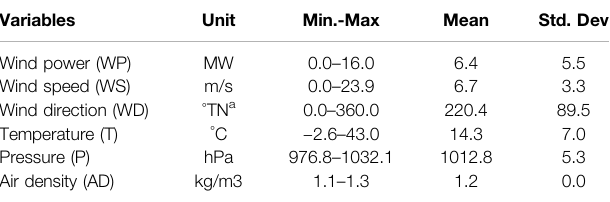
TABLE 2 | Summary of the descriptive statistics of the NREL: ID61118